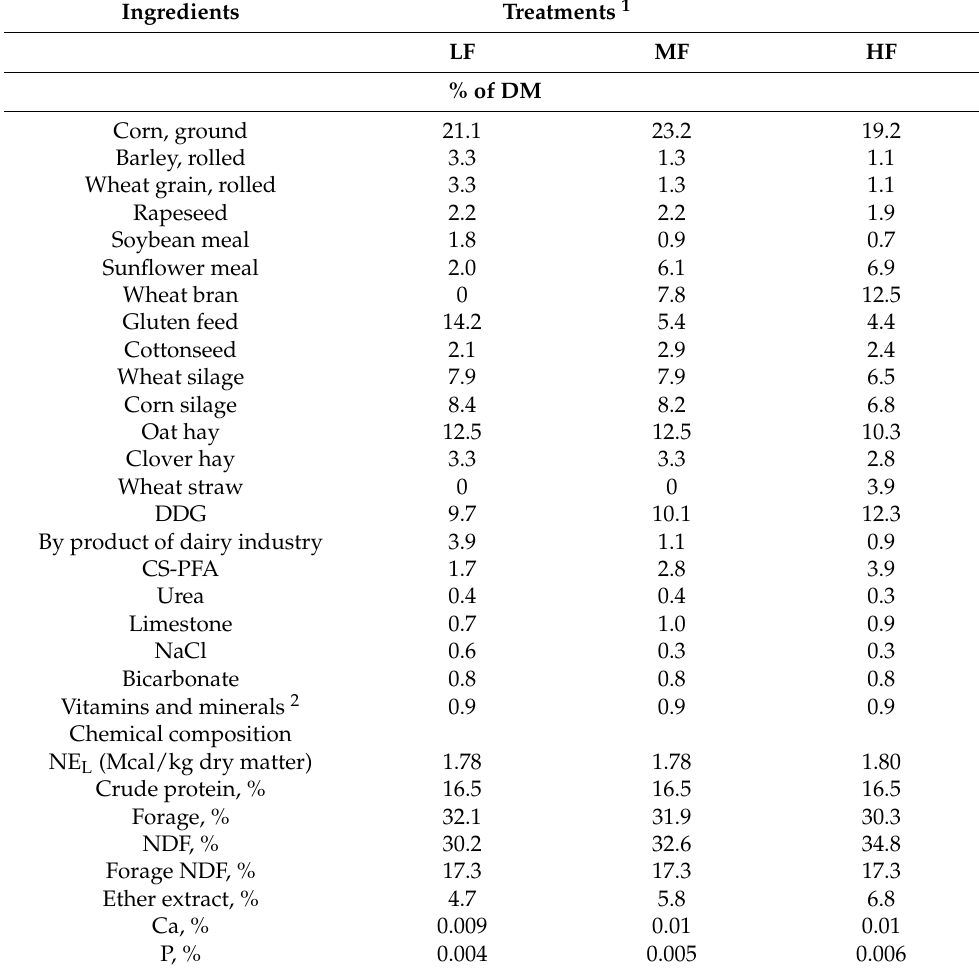
Table 1. Ingredients and chemical compositions of the experimental diets. Ingredients Treatments